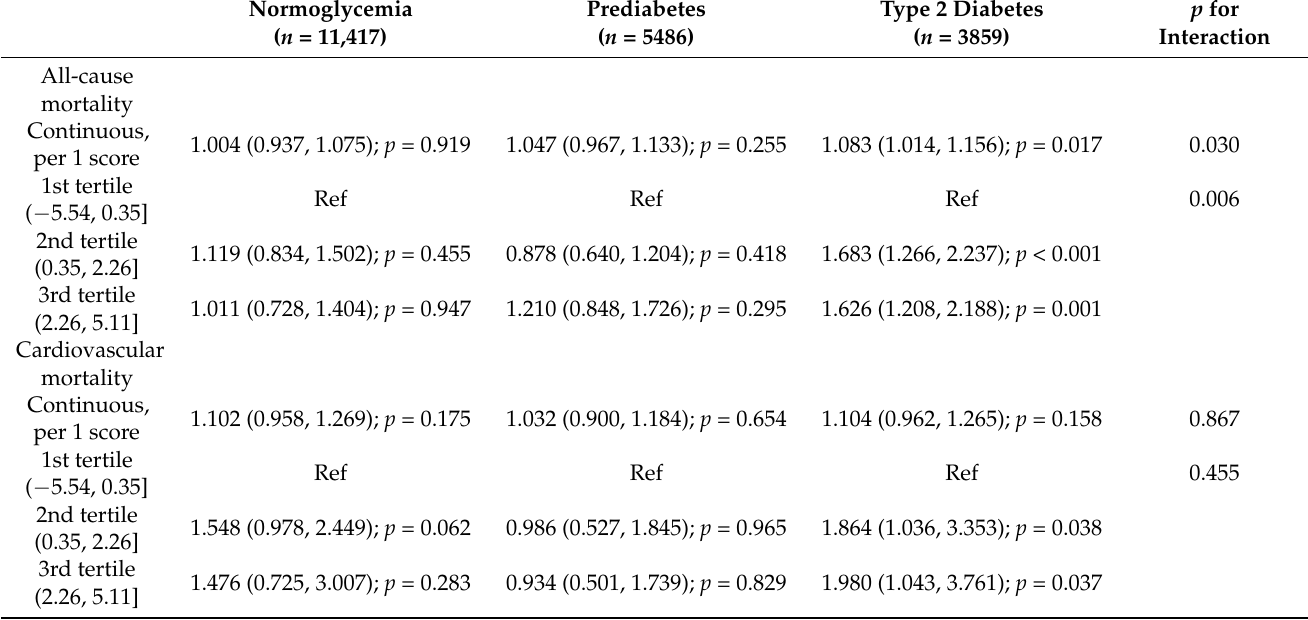
Table 3. Association between DII and the long-term mortality of participants by baseline glycemic status.